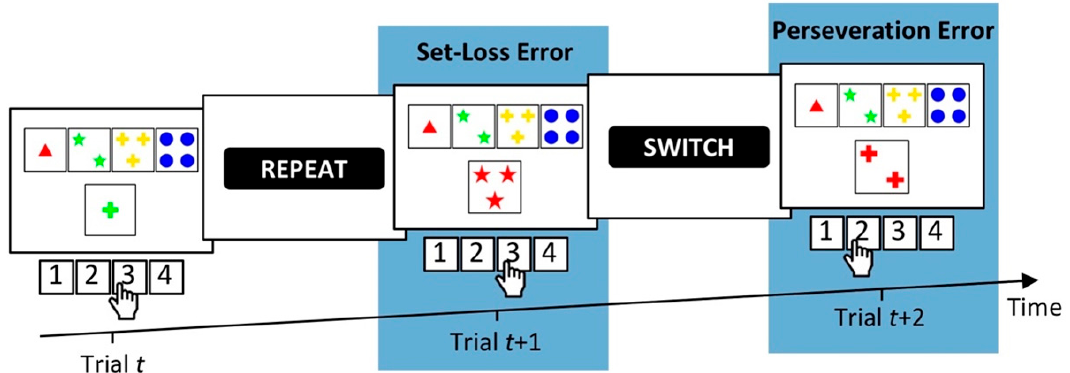
Figure 1. Three consecutive trials on a computerized variant of the Wisconsin Card Sorting Test (cWCST) [11,27–30]. The stimulus card on Trial t depicts one green cross. Applicable categories are the number category (far left key card, response 1), the color category (inner left key card, response 2), and the shape category (inner right key card, response 3). The execution of response 3 indicates the application of the shape category. A succeeding positive feedback cue (i.e., “REPEAT”) indicates that response 3 was correct and that the shape category should be repeated on the upcoming trials. Yet, on Trial t + 1, the execution of response 3 indicates the application of the number category. Set-loss errors refer to such erroneous switches of the applied category following positive feedback. A subsequent negative feedback cue (i.e., “SWITCH”) indicates that response 3 was incorrect. Hence, the applied category should be switched. However, on Trial t + 2, the execution of response 2 indicates an erroneous repetition of the number category. Perseveration errors refer to such erroneous category repetitions after negative feedback.